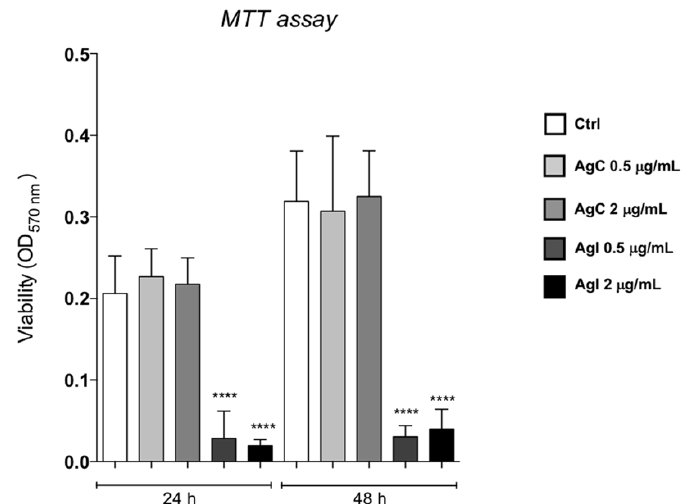
Figure 1. E ff ects of AgC on HaCaT cell viability. MTT assay of HaCaT cells incubated for 24 or 48 h with colloidal (grey bars) or ionic silver (dark bars) at 0.5 or 2 µ g / mL. Data are expressed as absorbance at 570 nm and presented as mean ± SE of three independent experiments, each done in sestuplicate. Analysis of variance was performed by two-way Anova followed by the Bonferroni post-test. **** P < 0.0001 when compared with the